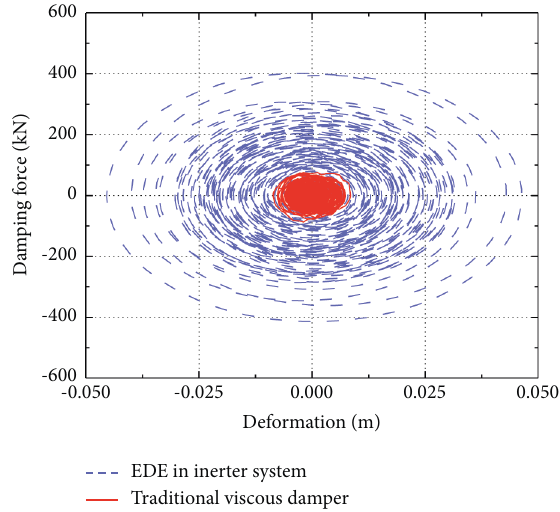
Figure 16: Hysteresis curves of a viscous damper within an inerter system and traditional viscous damper (the damping coefficients are identical) under seismic